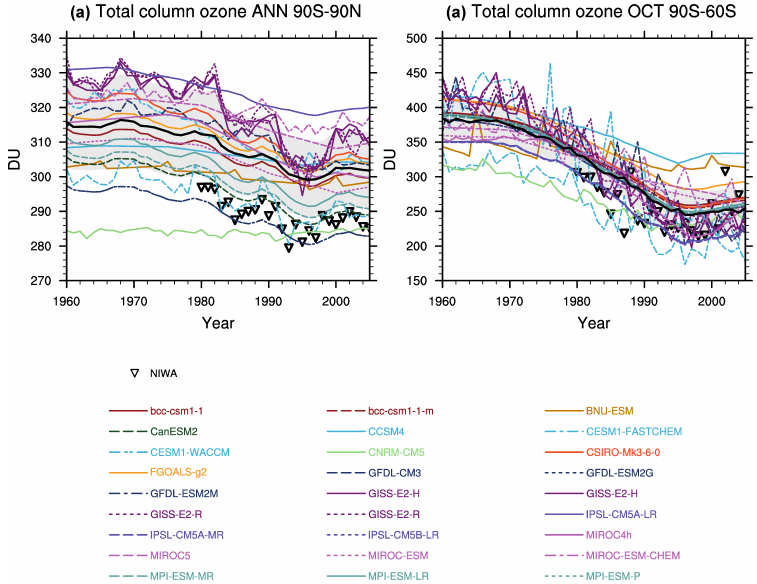
Figure 25. Total column ozone time series for (a) annual global and (b) Antarctic October mean. CMIP5 models are shown in coloured lines and the multi-model mean in thick black, their standard deviation as grey shaded area, and observations from NIWA (black triangles). The CMIP5 multi-model mean is in good agreement with observations, but significant deviations exist for individual models with interactive chemistry. Based on Fig. 2 of Eyring et al. (2013) and reproducing Fig. 9.10 of Flato et al. (2013), with namelist_eyring13jgr.xml